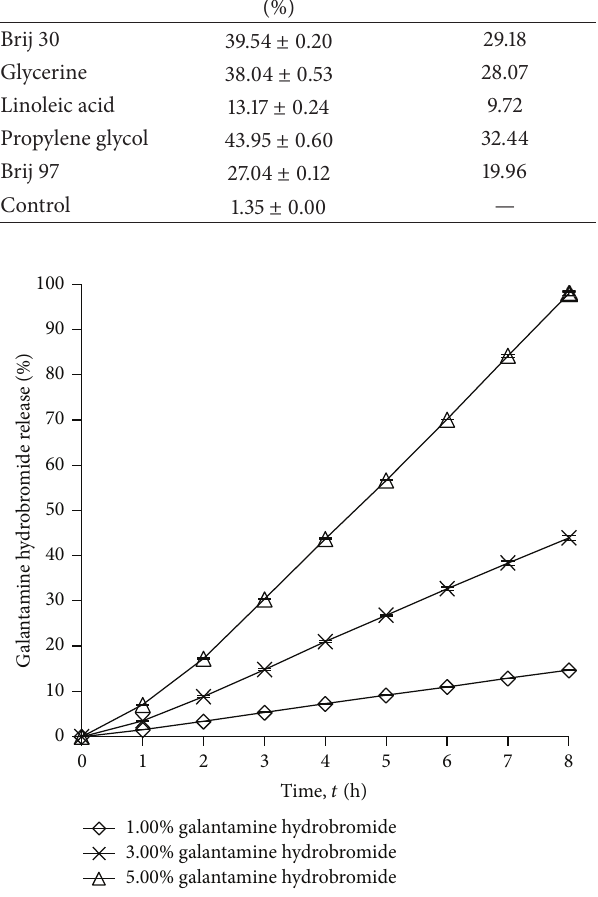
Figure 3: Drug release profile of gel drug reservoirs with different galantamine hydrobromide percentage (mean ± S.D.; 𝑛 = 3 ).